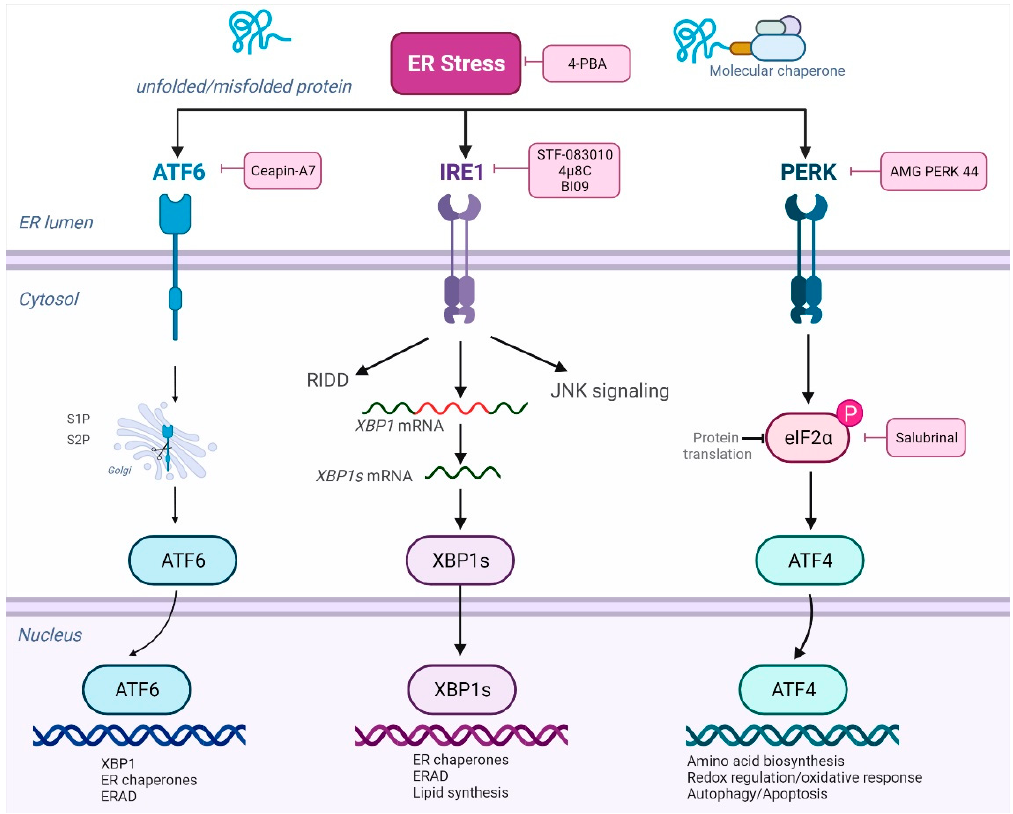
Figure 2. ER stress, the UPR and pharmacological inhibitors. ER stress can be prevented with the use of chemical chaperones, such as 4-PBA. Accumulation of proteins in the ER lumen activates the UPR , which involves three master regulators: ATF6, IRE1 and PERK, which have their ER luminal domains bound to BiP in their inactive domains. After BiP dissociation, ATF6 travels to the Golgi and proteases S1P and S2P cleave the cytoplasmic domain of ATF6, which then translocates to the nucleus, where it activates cytoprotective genes including those encoding ERAD components and ER chaperone. ATF6 signaling can be selectively inhibited with molecules such as ceapin-A7. When BiP is released, IRE1 α activates endoribonuclease and the splicing of X-box-binding protein 1 ( XBP1 ) mRNA. Spliced XBP1 ( XPB1s ) translocates to the nucleus and upregulates genes involved in mitigating the protein burden. IRE1 signaling can be inhibited with molecules such as 4 μ 8C, BI09 and STF-083010. Once activated, PERK phosphorylates eIF2 α and activates Atf4 mRNA to produce the activating transcription factor 4 (ATF4), involved in the activation of genes related to adaptation and relief of ER stress and oxidative stress. PERK signaling can be inhibited with molecules such as AMG PERK 44. Salubrinal can selectively inhibit eIF2 α dephosphorylation. Created with BioRen- der.com. 4. Molecular Chaperones Molecular chaperones act to prevent aberrant protein aggregation by binding to un- folded and misfolded proteins [7,17]. In addition, they participate in biogenesis of MHC class I and class II molecules [94] and in antigen presentation [95], thereby having an im- portant role in immunity. Given their conserved nature and abundance, particularly in stressed states, these molecules become favorable targets for regulatory T cells [96], and autoantibodies against molecular chaperones such as calnexin, GRP78 and GRP94 have been identified in SLE and RA, as well as numerous other rheumatic and inflammatory diseases [97,98]. GRP78 is a molecular chaperone and a key regulator of ER homeostasis, implicated in humoral and cellular autoimmune responses in RA, and a putative autoantigen in the disease [99–101]. Anti-GRP78 autoantibodies have been found in sera of as many as 63% of patients with RA, compared to 7% of patients with other RMDs and only 1% of healthy